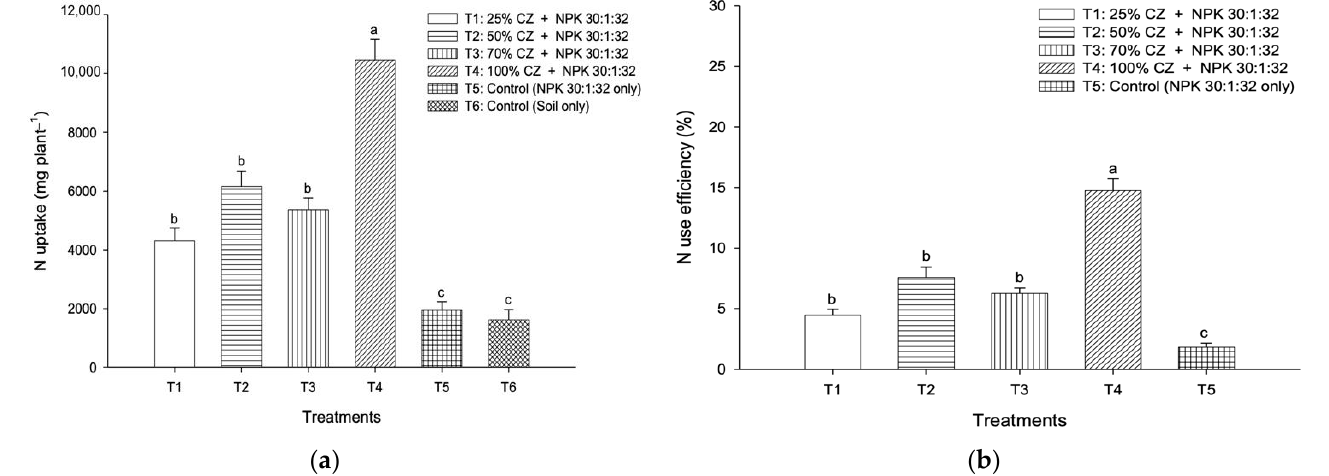
Means (value ± standard error) with different letters within the same column are significantly different according to Tukey’s test at p ≤ 0.05.